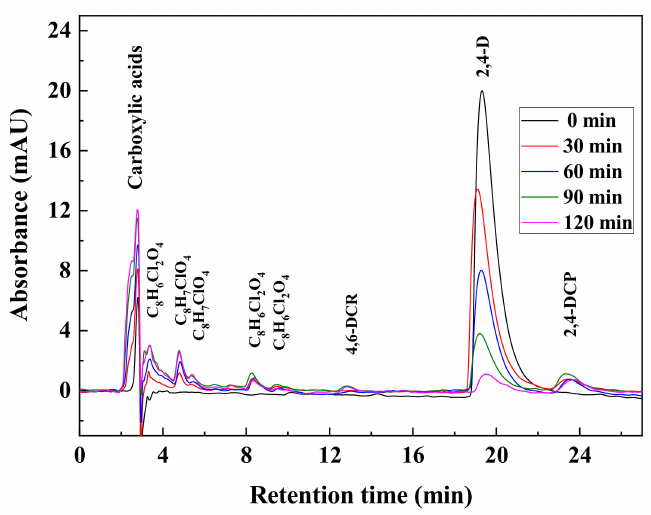
Figure 9. HPLC chromatograms during the RFD treatment (input power, 200 W; [2,4-D] 0 , 1.0 mM; pH 0 ,